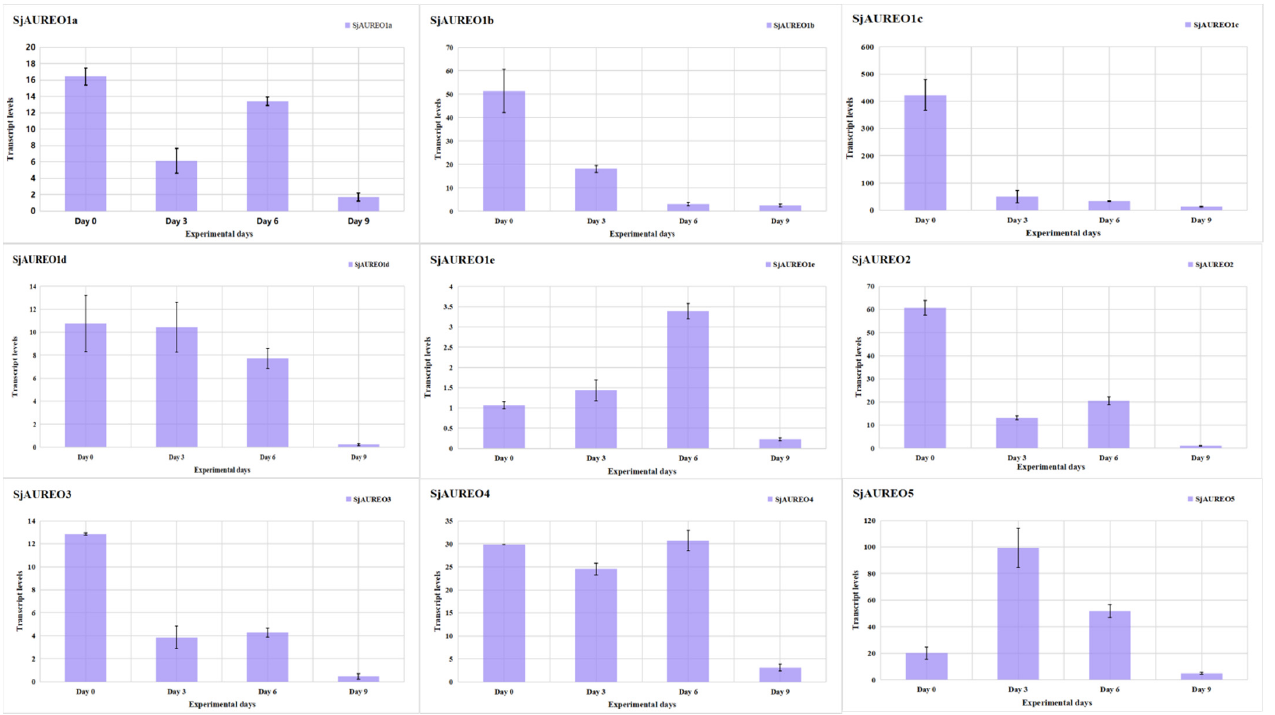
Figure 5. Differential expression of nine AUREO genes in S. japonica at different developmental stages. (Dormant period: Day 0; Vegetative growth period: Day 3; Vegetative growth peak: Day 6: Gametophyte development period: Day 9). The change trend of Sj AUREO-related expression levels extracted from the transcriptome. The initial state is dormant in weak light and low temperature at 4 °C on day 0, and then transferred to long photoperiod (16 Light:8 D ark ) at 10 °C with nitrogen, phosphorus, and iron concentrations of 4 mg/L, 0.4 mg/L, 0.2 mg/L, and white light of 60 μ mol photons/(m 2 ·s). Samples were taken on days 0/3/6/9 of the experiment, with three replicates in each phase.